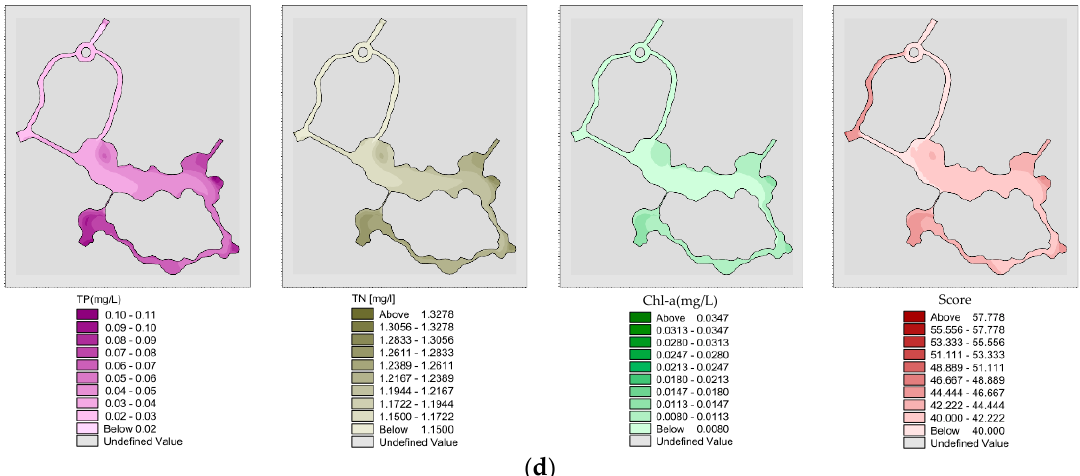
Figure 19. ( a ) Spatial distribution of “unilateral” river TP, TN, Chl-a and eutrophication scores after pumping 22 h in winter, when river model reached a completely steady state; ( b ) Spatial distribution of “unilateral” river TP, TN, Chl-a and eutrophication scores after pumping for 30 h in winter; ( c ) Spatial distribution of “bilateral” rivers TP, TN, Chl-a and eutrophication score after pumping. 22 h in winter; ( d ) Spatial distribution of “bilateral” rivers TP, TN, Chl-a and eutrophication score after pumping for 30 h in winter.